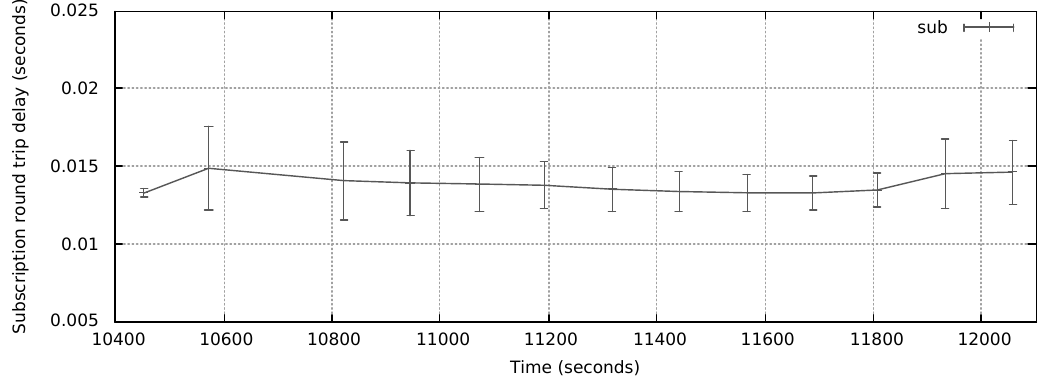
Figure 18. Mean round trip time of APS subscriptions for Wi-Fi channel changing command from PSS. Wi-Fi network delay between Host 1 and Host 2 is included twice.